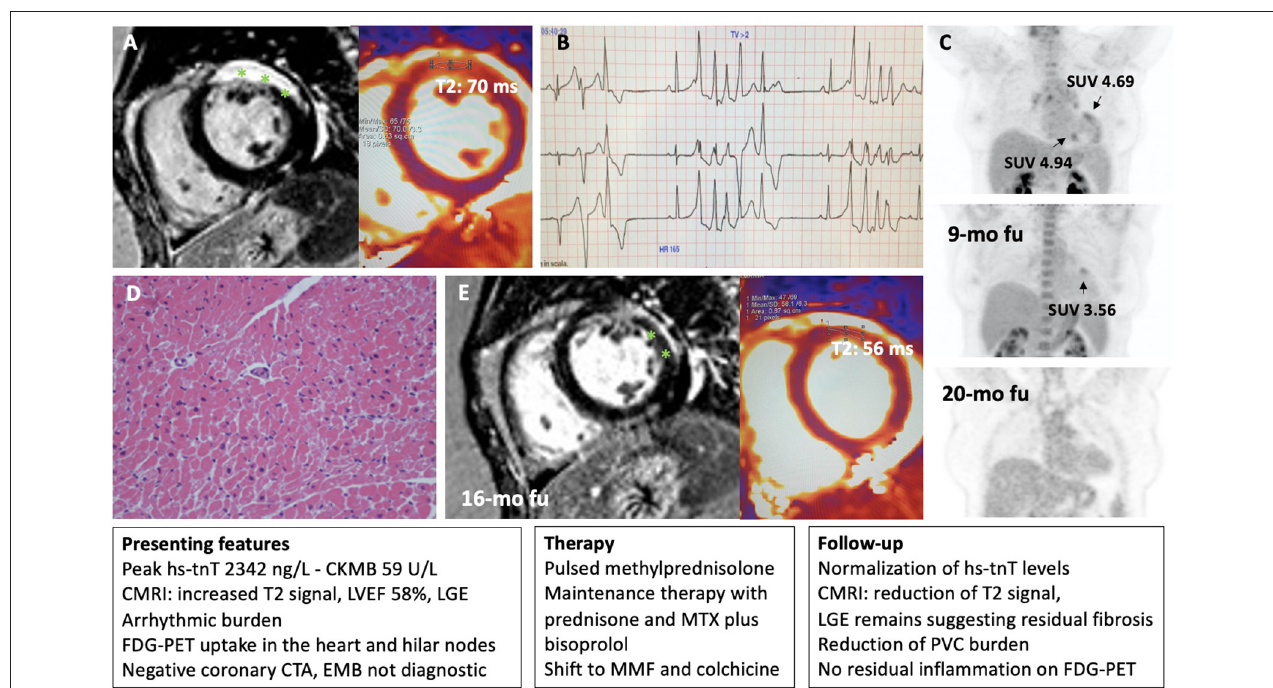
FIGURE 5 | Representative patient with acute myocarditis in whom immunosuppression was guided by FDG-PET and cardiac magnetic resonance imaging (CMRI). A 49-year-old woman with a previous history of ANA positive pericarditis presented with acute myocarditis. On CMRI she presented a transmural lesion in the anterior wall as demonstrated by late gadolinium enhancement (LGE, highlighted with asterisks) and increased T2 signal (normal value < 55ms) (A) . Left ventricular ejection fraction (LVEF) remain preserved, but a ventricular arrhythmic burden was observed on telemetry monitoring with frequent premature ventricular complexes (PVC) and non-sustained ventricular tachycardia (NSVT) (B) . An FDG-PET showed 3 focal areas of uptake in the heart with increased standardized uptake values (SUV), and an uptake in hilar nodes raising the suspect for cardiac sarcoidosis (C) . A septal endomyocardial biopsy (EMB) from the right ventricle was non-diagnostic for myocarditis or cardiac sarcoidosis (D) . Peak high sensitivity troponin T (hs-tnT) levels was 2,342 ng/L. After initial pulsed methylprednisolone, prednisone was started in combination with methotrexate (MTX) and later shift to mycophenolate mofetil (MMF) and colchicine plus bisoprolol with normalization of troponin levels, and no signs of residual inflammation on FDG-PET (C) , and a reduction of PVC burden. Accordingly, CMRI showed a reduction of T2 signal while LGE remains suggesting an area of residual fibrosis (E)